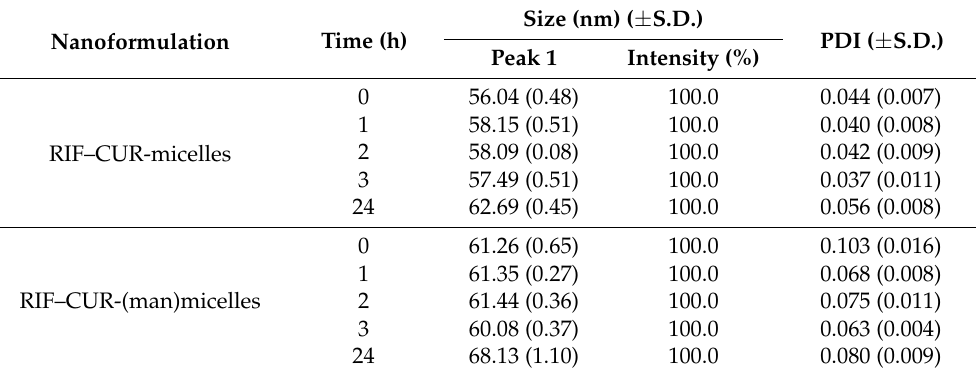
Table 3. Micellar size and size distribution of the RIF(10 mg/mL)-CUR (5 mg/mL)-loaded micelles (10% w / v ) with and without mannose at 37 ◦ C in simulated interstitial lung medium (SILF, pH 7.4, sample dilution 1/50) over 24 h. Data are expressed as mean ± S.D. (n = 5). Size (nm) ( ± S.D.) PDI ( ± S.D.) Nanoformulation Time (h) Peak